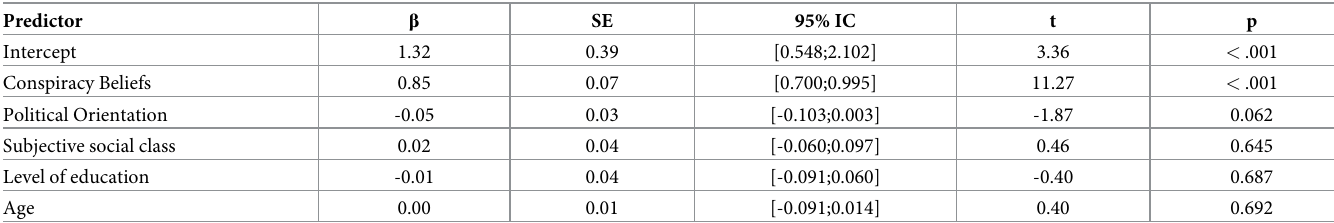
Table 7. Regression analysis to predict credibility towards science (Study